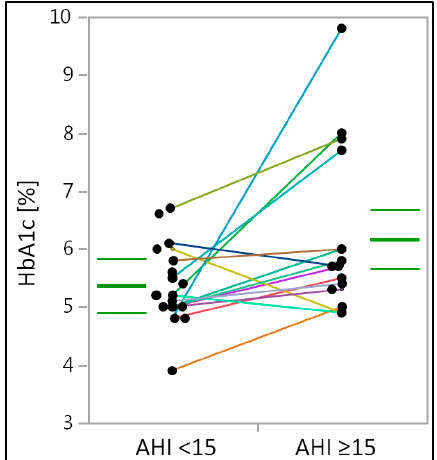
Figure 2. Glycated hemoglobin in obese individuals with mild or moderate to severe obstructive sleep apnea. HbA1c—glycated hemoglobin. HbA1c—levels are presented in percentages. Within the figure, median and IQR are given (bold and thin green lines, respectively) and individuals are visualized using dots and lines for their matching partners. Solitaire points represent individuals without matching partners or missing blood sample